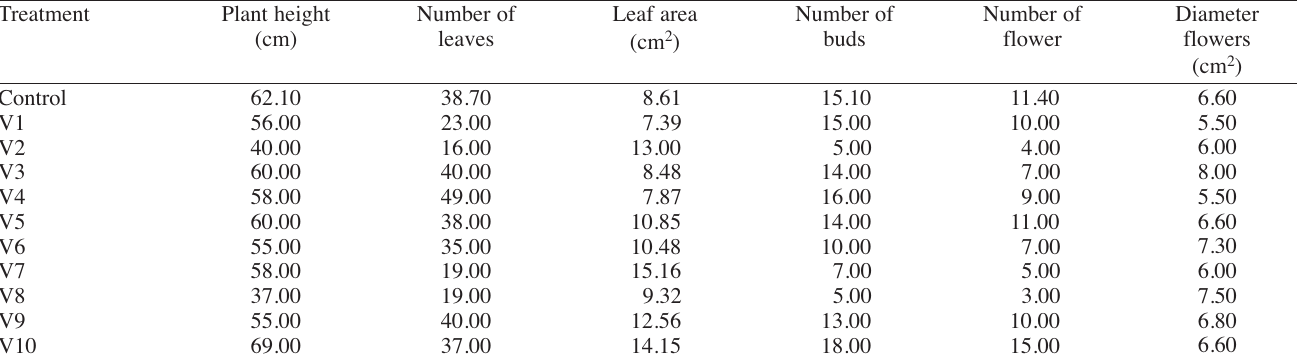
Table 3 - Effect of gamma radiation (10 Gy) on morphological characters in D. grandiflora